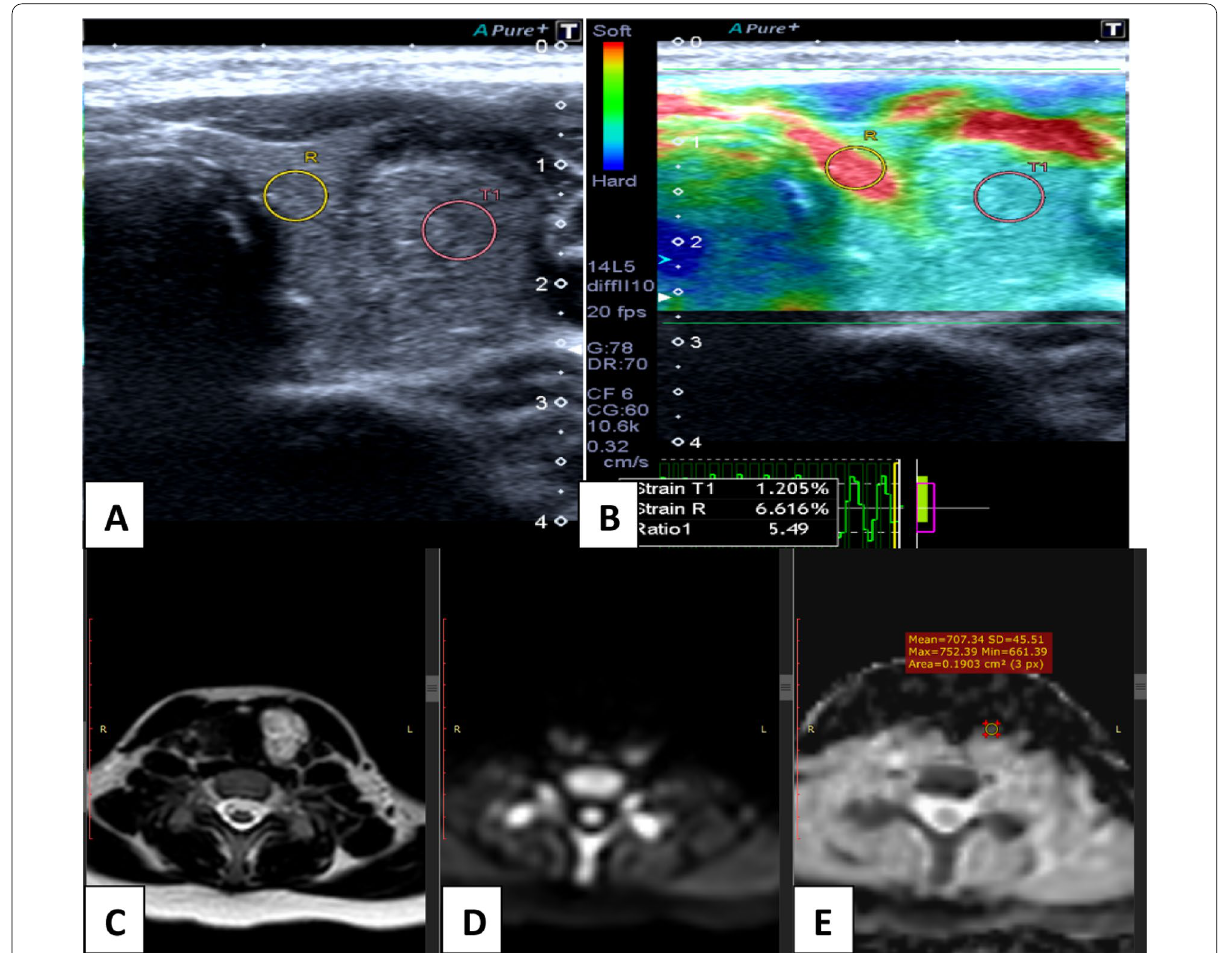
Fig. 5 Female patient aged 42 years presented with left lobe nodule. Ultrasound features of the nodule A : The left lobe shows a solid hypoechoic nodule, taller more than wider with well-defined outline. Micro calcifications are seen inside. TIRADS categorization: TIRADS (5). On elastography color map B : the entire nodule is evenly shaded blue. Elastography score: (4) Strain ratio 5.49. MRI study: T2 weighted images C : left lobe nodule is = seen showing mixed high and intermediate signal intensities. Diffusion weighted images D : areas of high signal intensity is seen within the nodule. ADC mapping E : it shows low signal with ADC value 0.7 10 − 3 . Pathology: follicular thyroid = ×